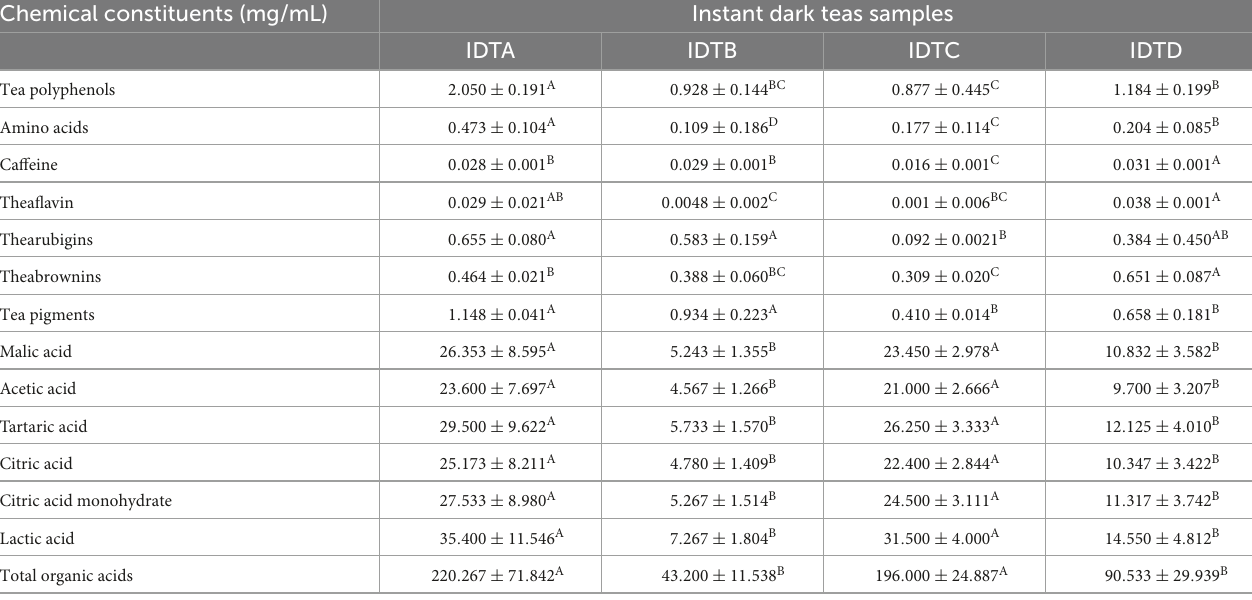
TABLE 1 Chemical constituents of instant dark teas fermented in liquid-state by A. cristatus , A. niger , and A. tubingensis . Chemical constituents